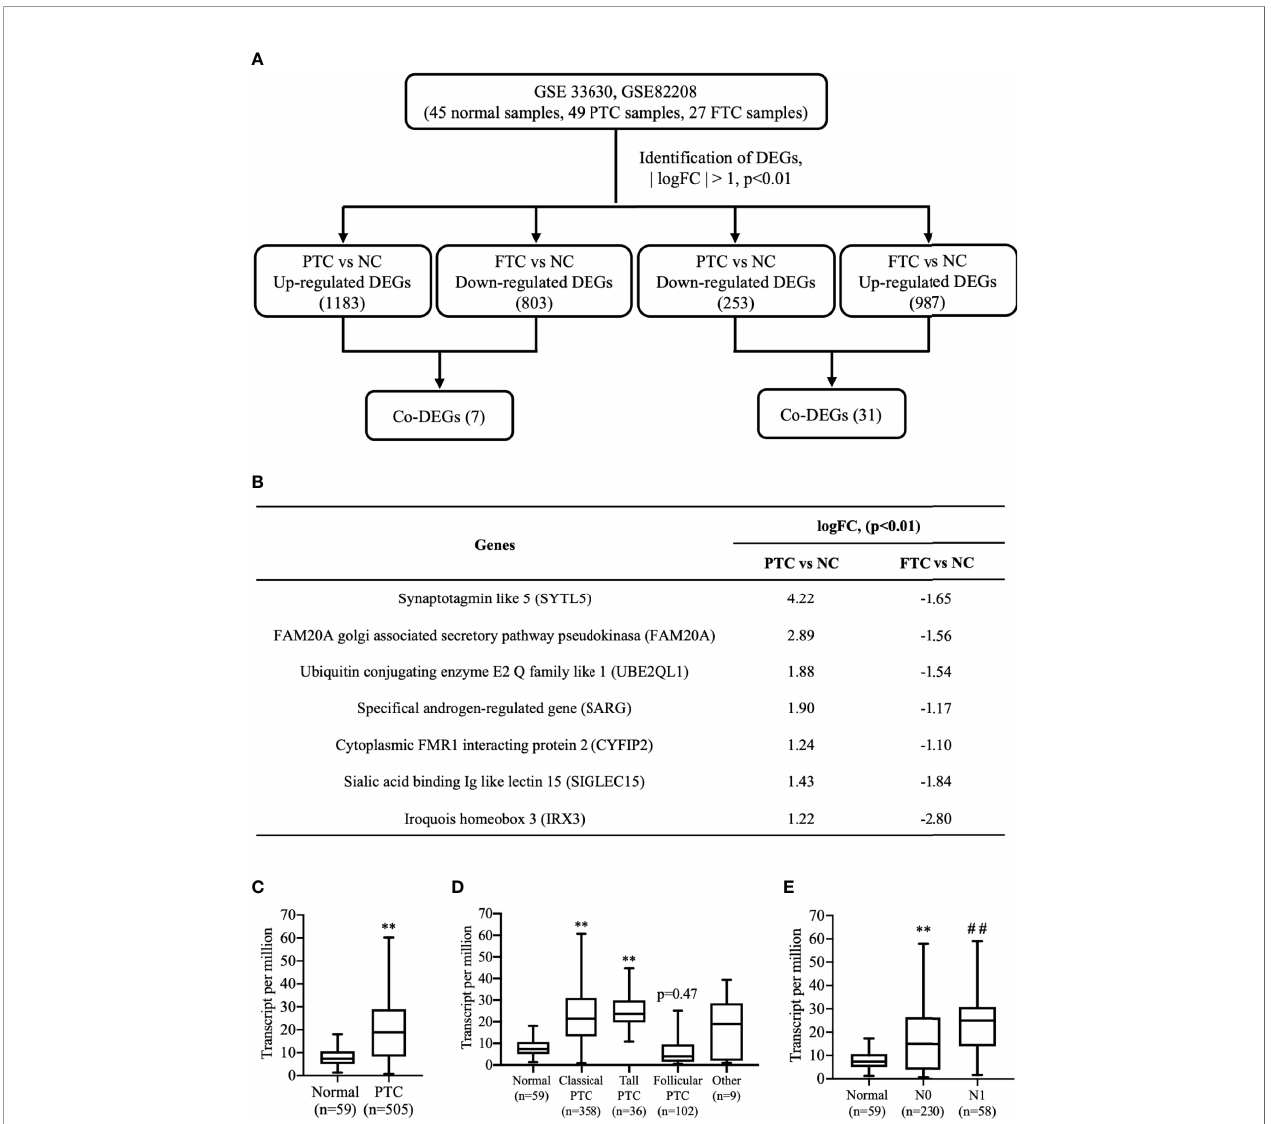
FIGURE 1 | Finding SARG overexpression associated with lymph node metastasis of PTC by analysis of GEO and TCGA database. (A) Brief scheme for screening the DEGs between PTC and FTC by GEO database analysis. (B) The list of 7 genes is up-regulated in PTC and down-regulated in FTC. (C) The expression of SARG between PTC and normal thyroid tissue from TCGA database. **, p<0.01 compared with Normal. (D) Expression of SARG in PTC based on tumor histology. **, p<0.01 compared with Normal. (E) Expression of SARG in PTC based on nodal metastasis status, **, p<0.01 compared with Normal; ## p<0.01 compared with N0, N0: no regional lymph node metastasis, N1: thyroid cancer with lymph node metastases in the axillary region. SARG, speci fi cally androgen-regulated gene; PTC, papillary thyroid carcinoma; GEO, Gene Expression Omnibus; TCGA, The Cancer Genome Atlas; FTC, follicular thyroid carcinoma; DEGs, differentially expressed